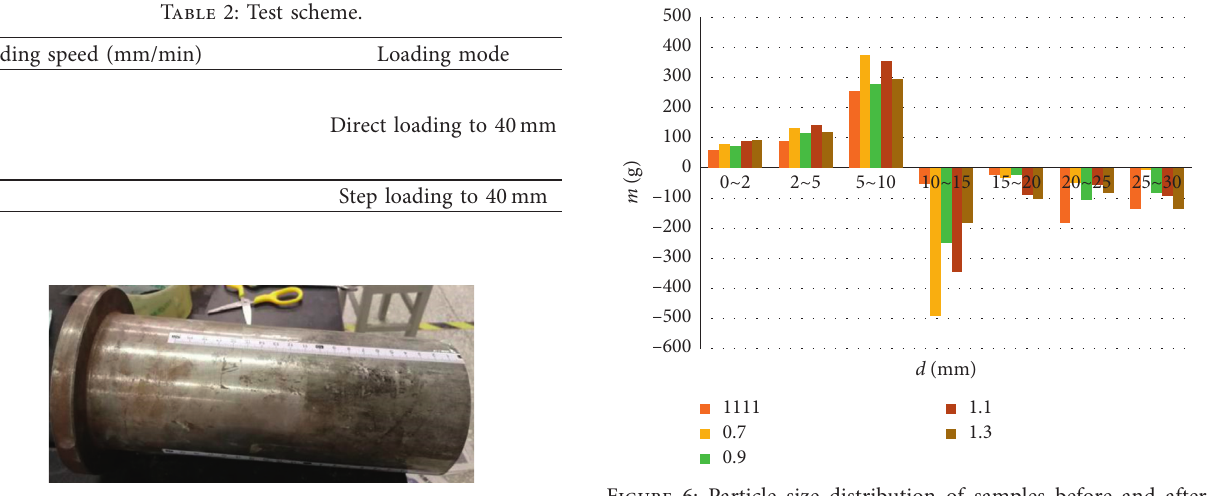
Figure 4: The hollow piston posted with scale papers.